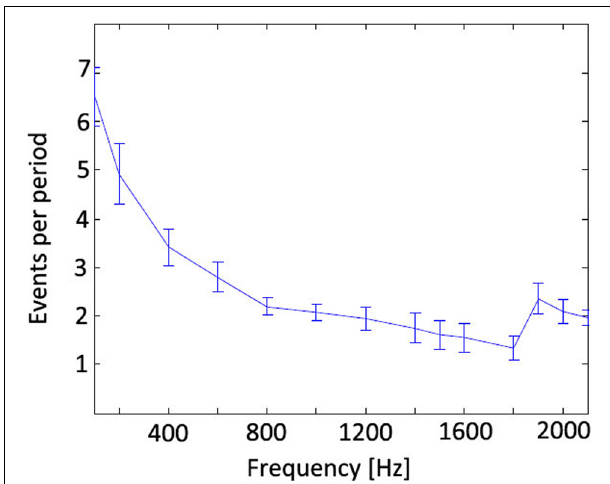
FIGURE 8 | Artificial 3D rapid prototype terrain used for proof of concept reconstruction. Blue: area depicted in Figure 9 , Red: laser line, Black: scan